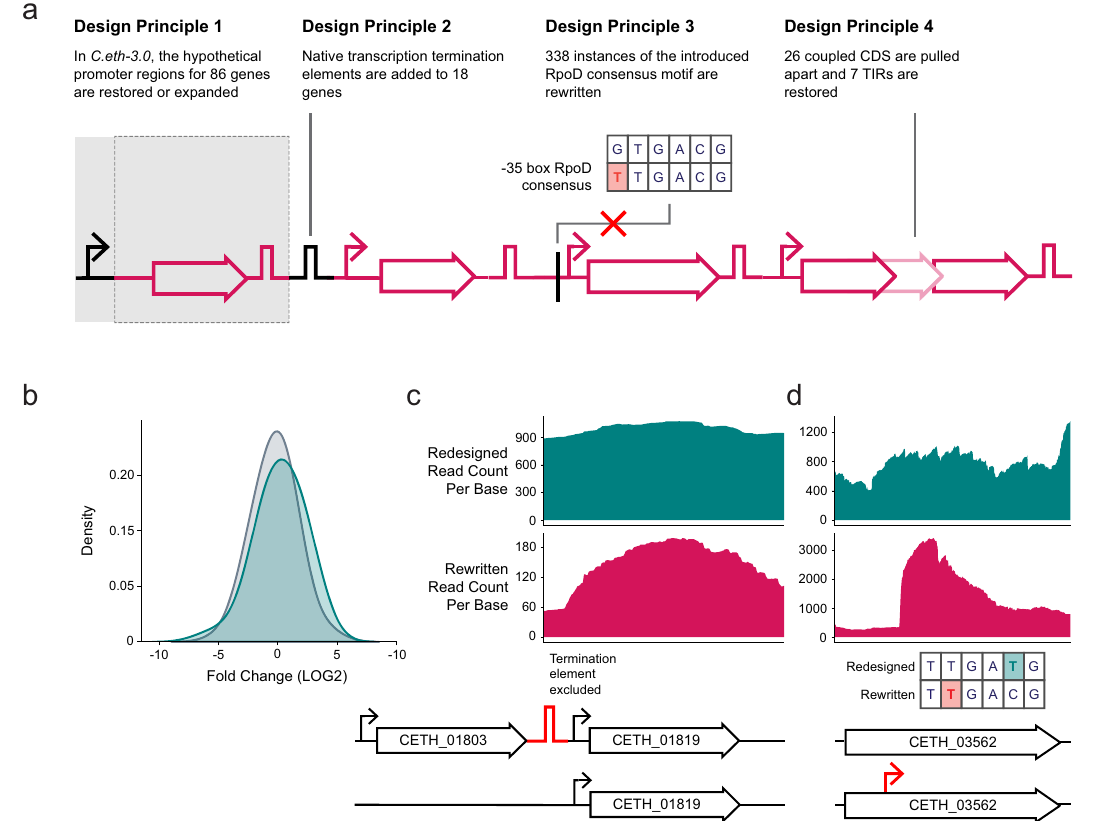
Fig. 2 Principles for synthetic genome design, to be implemented in C. eth-3.0 . Based on observed changes in the transcription level and transcription curve, analysis of the nucleotide sequence, conservation, and structural analysis, and, for selected cases, experimental validation, we suggest to implement the principles depicted. We redesigned a subset of 82 CDS and noncoding genes according to these principles. b Expansion or repair of promoter regions increased the transcription level for 11 of 12 assessed genes and the distribution of the fold changes of all measured genes, depicted here as smoothed kernel density estimates, has shifted accordingly ( μ − 0.24, σ 1.69 (gray) to μ 0.21, σ 1.93 (teal)). c The placement of CETH_01803 in a different context to assess transcription termination shows read-through upon redesign into hfq (CETH_01819) d . Synonymous recoding of the promoter consensus motif in atpA (CETH_03562) removes the transcription start site that had been introduced unintentionally in C. eth-2.0 . Teal trace: redesigned transcription curve derived from redesigned read count, magenta trace: rewritten transcription curve derived from rewritten read